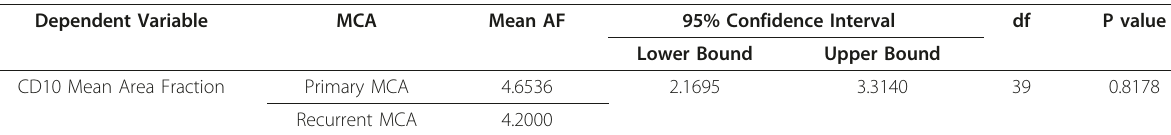
Table 3 Welch Two Sample t-test (CD10)